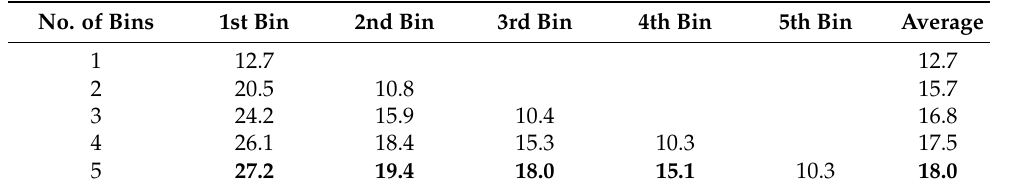
Table 8. The average number of items in each bin in case of multibin packing.